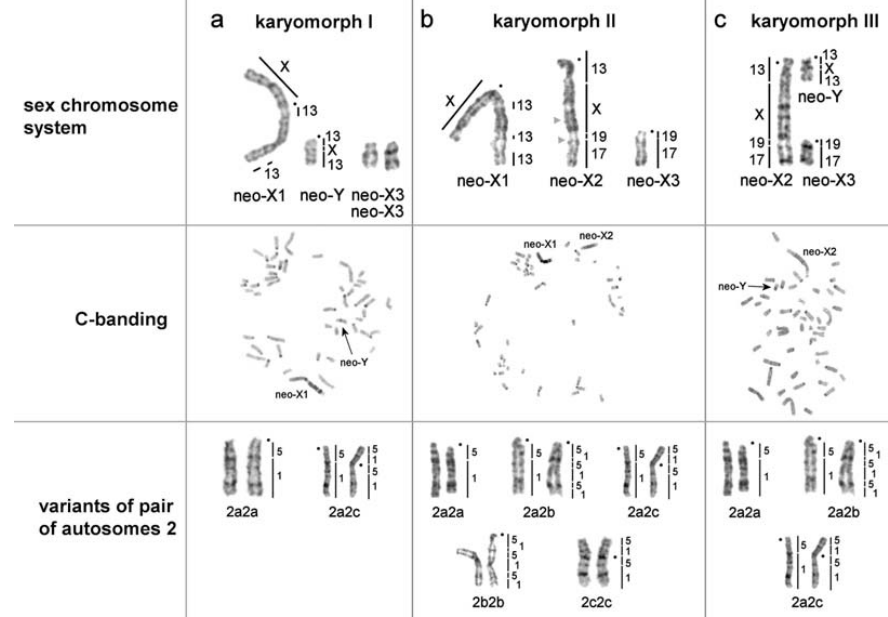
Figure 3. Polymorphic sex chromosomes and a pair of autosomes 2 in karyotypes of Lasiopodomys mandarinus vinogradovi : (a) Males (karyomorph I), (b) females, karyomorph II, (c) females, karyomorph III. From top to bottom: Sex chromosome system in the karyomorph, C-banding of metaphase chromosomes (chromosomes of LMAN10m (a), LMAN19f (b), and LMAN14f (c) are given as an example for each karyomorph), a pair of autosomes 2 of di ff erent individuals with localization of Microtus agrestis samples. Black arrows marked possible